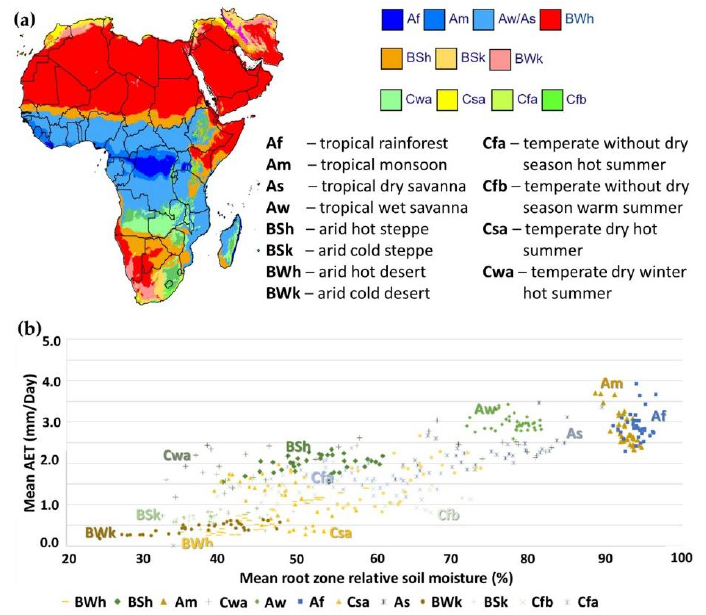
Figure 10. ( a ) Koeppen–Geiger climate classifications across the WaPOR domain of the Africa and the Middle-East; ( b ) Mean Actual Evapotranspiration (AET) versus root zone relative soil moisture (i.e., saturation degree) stratified by the Koeppen–Geiger climate classifications.